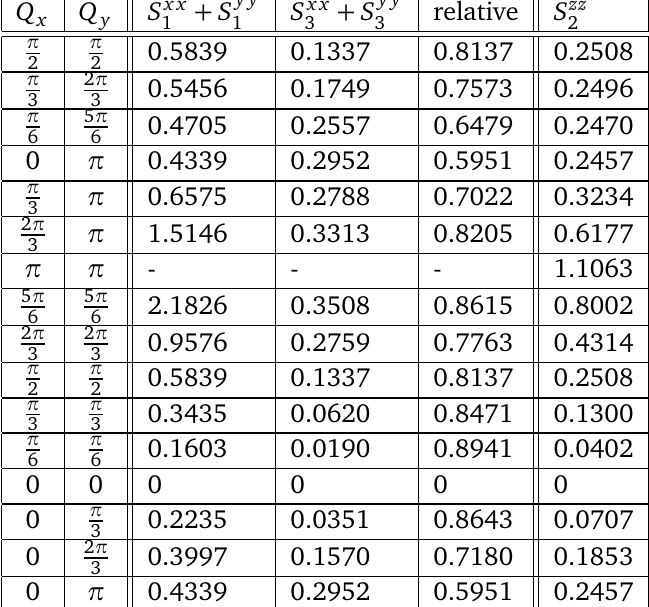
+ S y y ) / ( S xx + S y y + S xx + S y y ) . At Q = ( 0,0 ) the DSF are 1 1 3 1 1 3